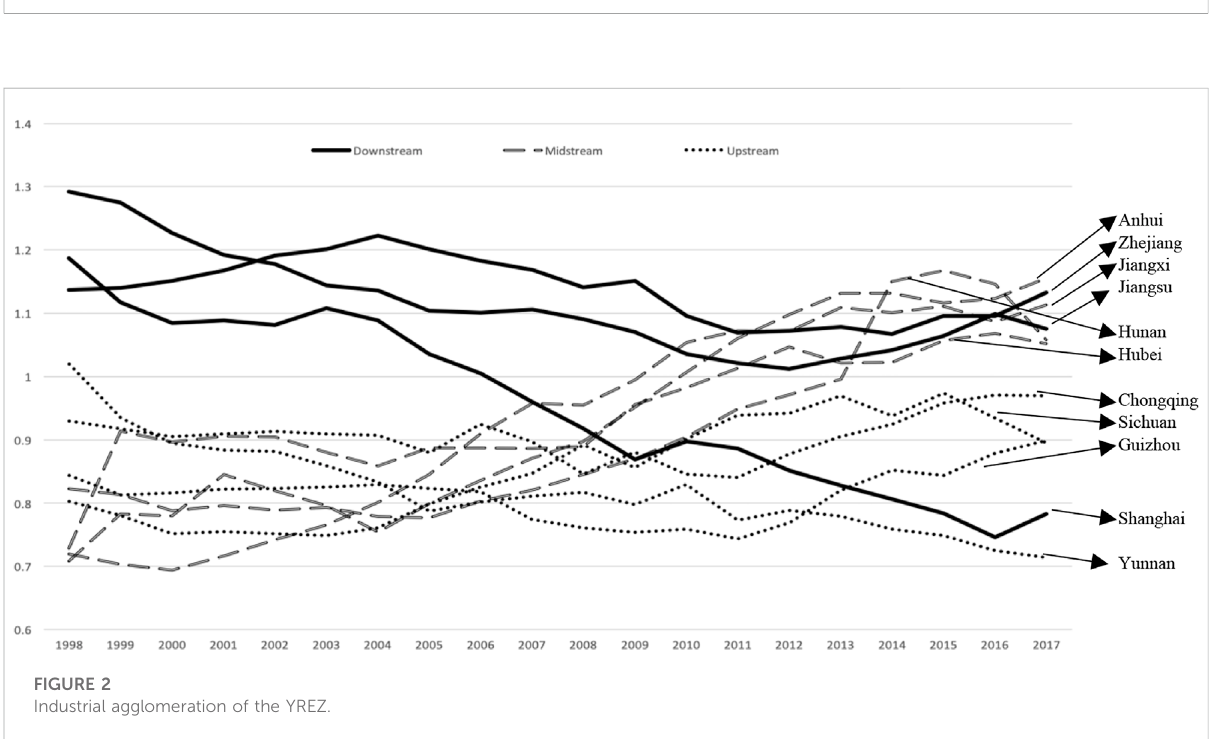
FIGURE 1 Water pollution of the YREZ. Light yellow represents the area with the least water pollution, as the color deepens, the degree of pollution becomes more serious, and dark red is the area with the most serious water pollution.